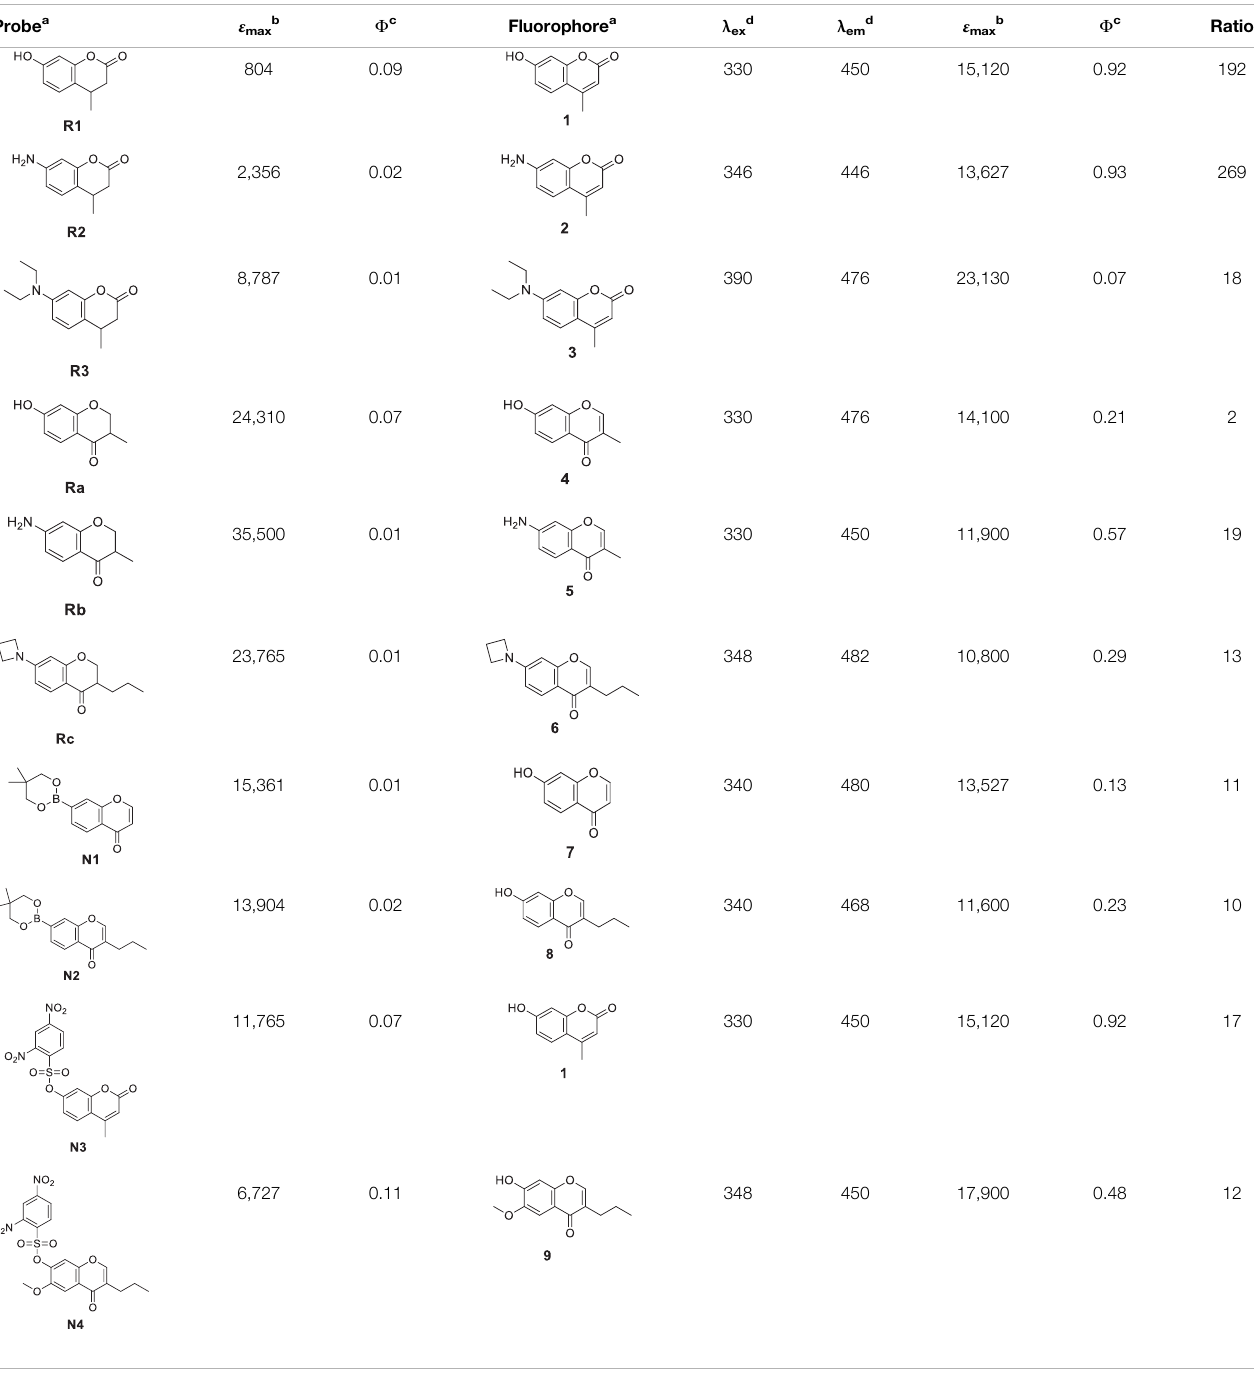
(cid:129) - probes and their fl uorophores.